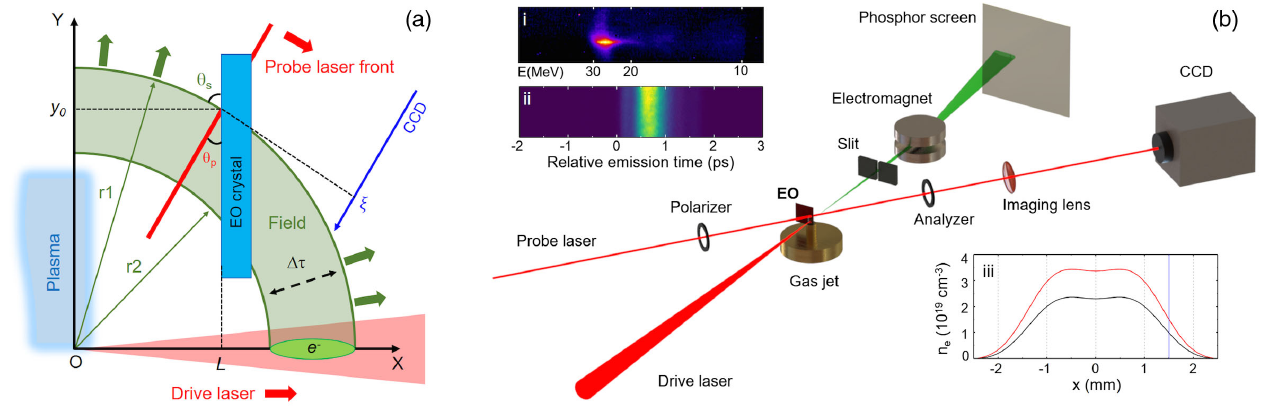
FIG. 1. Schematic of EO detection. (a) The physics concept of the EO detection when placing the crystal close to the source. Due to the shielding of plasma, the wavefronts of the electric fields have spherical shapes. (b) Experimental setup. The GaP crystal was placed 2.2 mm from the exit of the plasma in the longitudinal direction. The detection point had a transverse distance 1.5 mm aside from the drive laser axis. Insets (i) and (ii) are samples of the electron energy spectrum and EO signal recorded simultaneously in a single shot. (iii) is the measured plasma density profiles at two different back pressures with maximum densities of 2.3 (black) and 3.5 (red) × 10 19 cm − 3 . The blue line denotes the rear edge of the